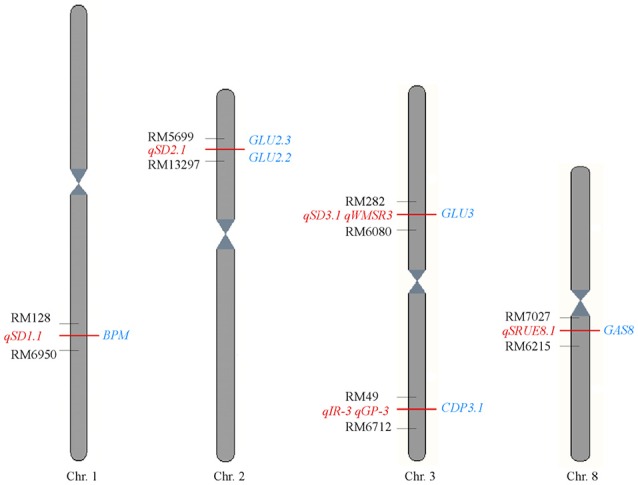
Comparison of position between the identified proteins here with the previous QTLs for seed germination among Jiucaiqing/IR26 RILs population. The proteins identified in this study are shown on the left (red), and the previously mapped QTLs are shown on the right (blue) (Wang et al., 2011, 2014; Cheng et al., 2013; Liu et al., 2014).